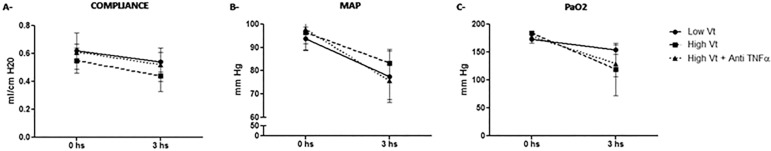
Monitoring during the experimental procedure. Changes in thoracic system compliance, mean arterial pressure and the partial pressure of arterial oxygen: ventilation with a high tidal volume was associated with decreased thoracic system compliance at 3 hours (p = 0.04), and comparison of the high tidal volume group versus the adalimumab + high tidal volume group showed no differences regarding lung compliance (p = 0,26). All groups presented a mean arterial pressure drop over the 3 hours of the study with no significant differences. Ventilation with a high tidal volume was associated with hypoxemia compared with ventilation with a low tidal volume (p = 0.018), while the adalimumab-treated group showed no statistically significant differences at 3 hours compared with the high tidal volume group (p = 0.42).MAP - mean arterial pressure; PaO2 - partial pressure of arterial oxygen; Vt - tidal volume; TNF-α - tumor necrosis factor alpha.